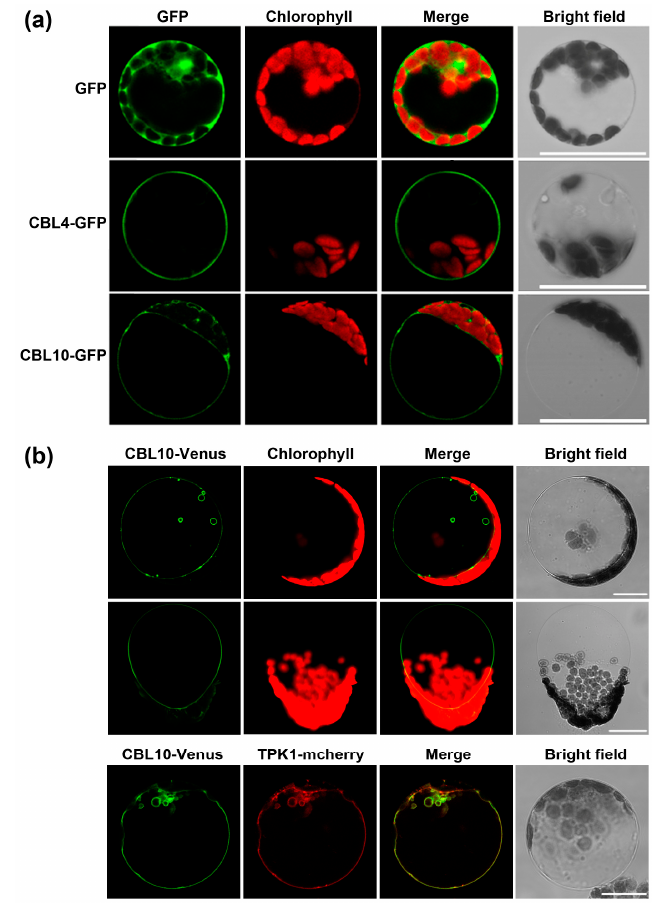
Figure 7. Subcellular localization of calcineurin B-like proteins 4 (CBL4) and CBL10. ( a ) Confocal laser scanning microscopy images of Arabidopsis mesophyll protoplasts transiently expressing either green fluorescent protein (GFP) alone or CBL4-GFP or CBL10-GFP fusion proteins under the control of the 35S promoter; ( b ) protoplasts generated from Agrobacterium-infiltrated Nicotiana benthamiana leaves expressing CBL10-Venus (upper row), a vacuole released from a mesophyll protoplast (middle row) and protoplasts co-expressing CBL10-Venus and TPK1-mcherry (lower row). The GFP / Venus signals (green), chloroplast auto-fluorescence / mcherry (red), merged signals from GFP / Venus and chlorophyll channels or from Venus and mcherry (yellow), and bright-field images are shown separately from left to right in each lane. Bars = 20 μ m.